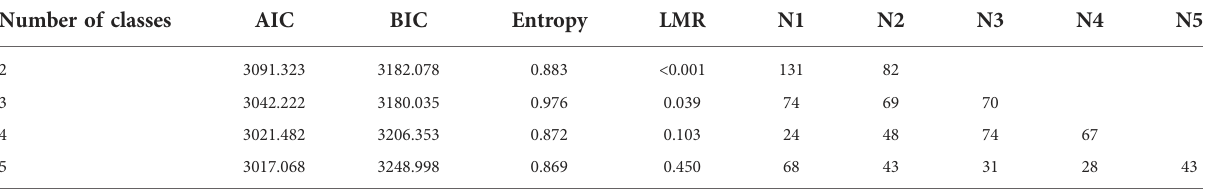
TABLE 6 Selection of the best model.